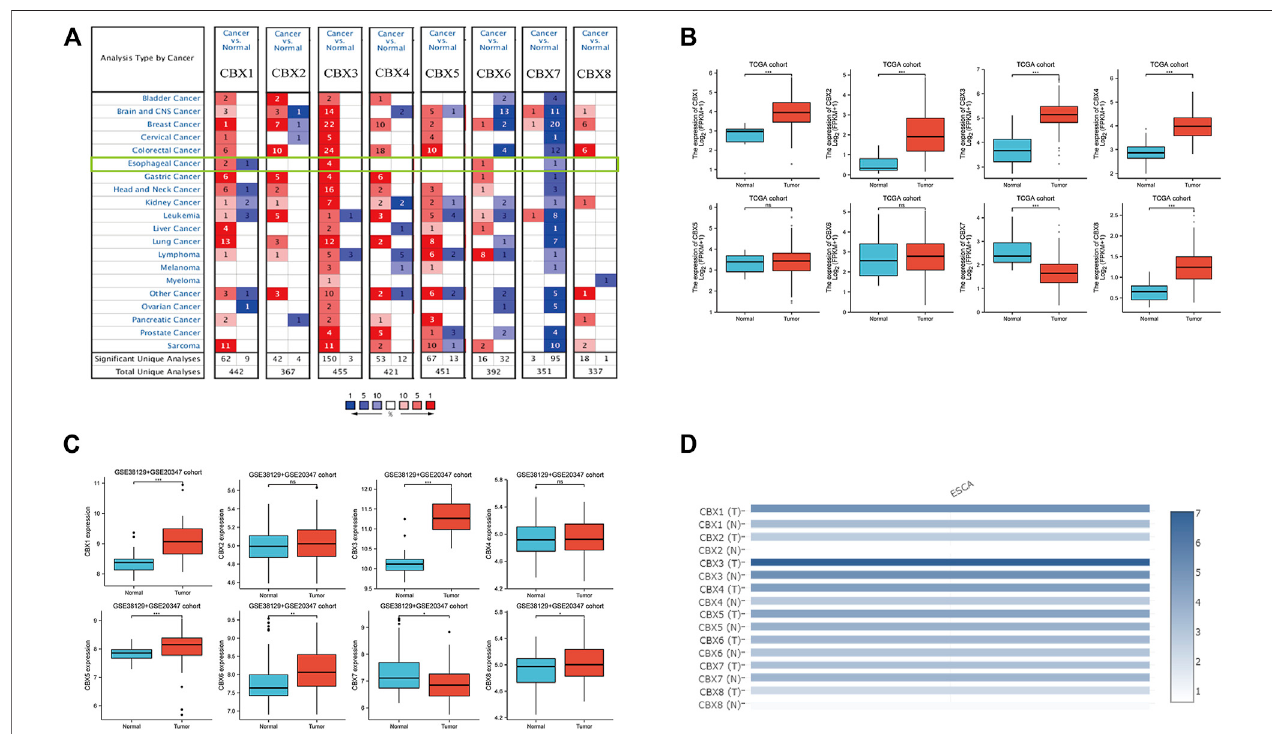
FIGURE 1 | Expression of CBX family members in ESCA and normal. (A) mRNA levels of CBX family members in various types of cancer (ONCOMINE). The fi gure showsthenumbersofdatasetswithstatisticallysigni fi cantmRNAoverexpression(red)ordownregulatedexpression(blue)ofCBXs.Cutoffof p value:0.05,foldchange: 1.5, gene rank: 10%, data type: mRNA. (B) Transcriptional of CBX family members in ESCA and normal (TCGA). (C) Expression of CBX family members in ESCA and adjacentnormal(GSE38129+GSE20347 cohort).The p valuewassetat 0.05. (D) RelativemRNA expression levelofCBXsinESCA andnormaltissues inGEPIA. Color intensity represents the fold change expression of the genes in the tissue. * p < 0.05, ** p < 0.01, *** p <